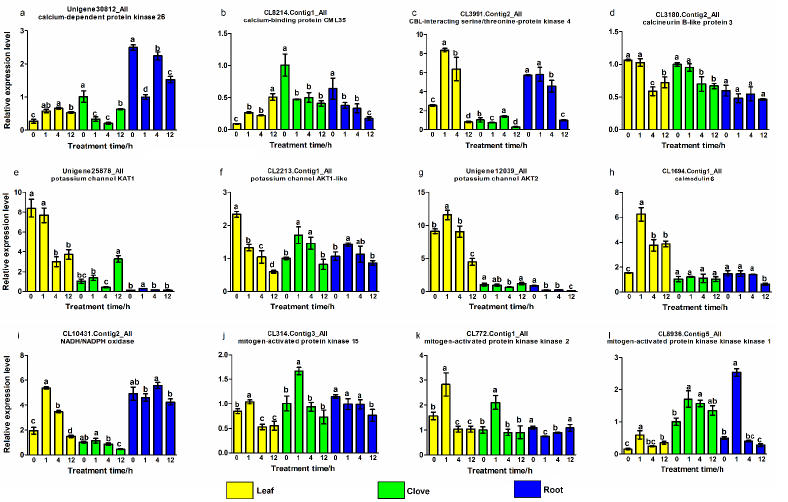
Figure 6. Expression patterns of genes involved in calcium signaling in garlic samples subjected to drought stress. Genes involved in calcium signaling include ( a ) calcium-dependent protein kinase 26 (Unigene30812_All), ( b ) calcium-binding protein CML35 (CL8214.Contig1_All), ( c ) CBL-interact- ing serine/threonine-protein kinase 4, ( d ) calcineurin B-like protein 3 (CL3180.Contig2_All), ( e ) po- tassium channel KAT1 (Unigene25878_All), ( f ) potassium channel AKT1-like (CL2213.Contig1_All), ( g ) potassium channel AKT2 (Unigene12039_All), ( h ) calmodulin 6 (CL1694.Contig1_All), ( i ) NADH/NADPH oxidase (CL10431.Contig2_All), ( j ) mitogen-activated protein kinase 15 (CL314.Contig3_All), ( k ) mitogen-activated protein kinase kinase 2 (CL772.Contig1_All), and ( l ) mi- togen-activated protein kinase kinase kinase 1. The different lowercase letters in the same tissue represent a significant difference at the 0.05